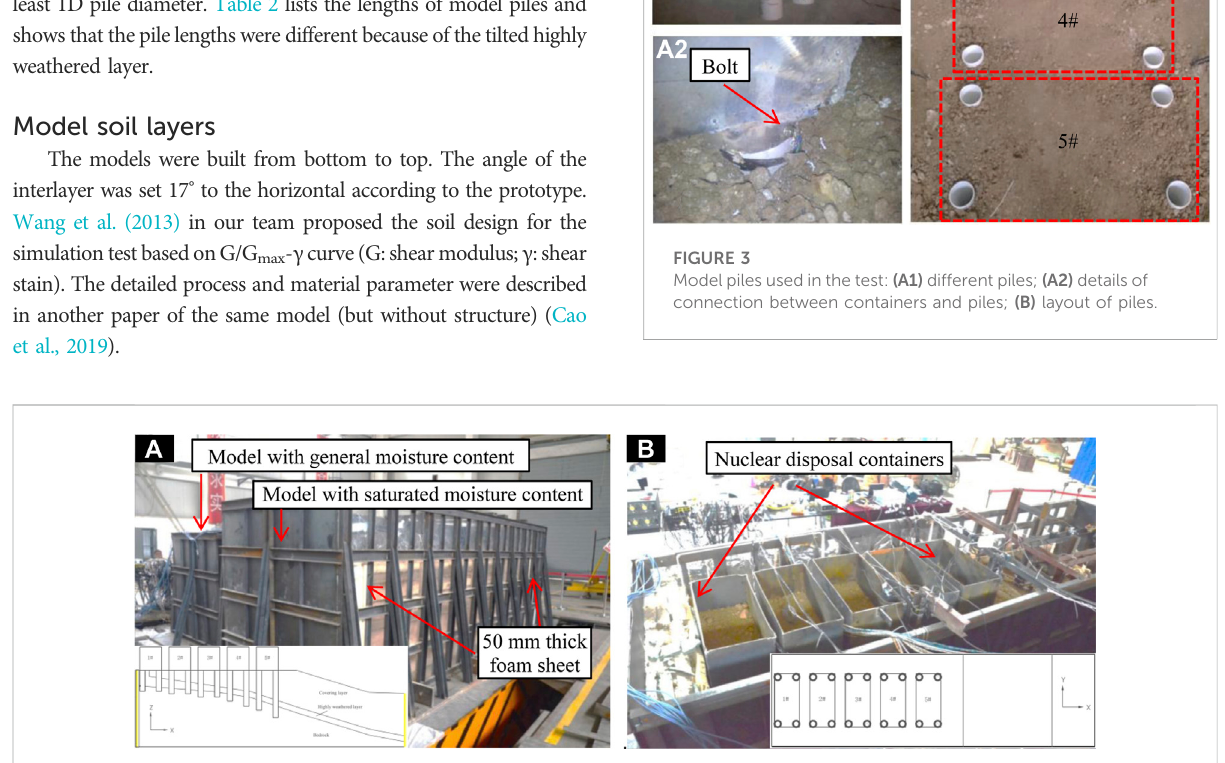
FIGURE 2 Steel boxes for the model: (A) different moisture content model; (B) nuclear disposal container.